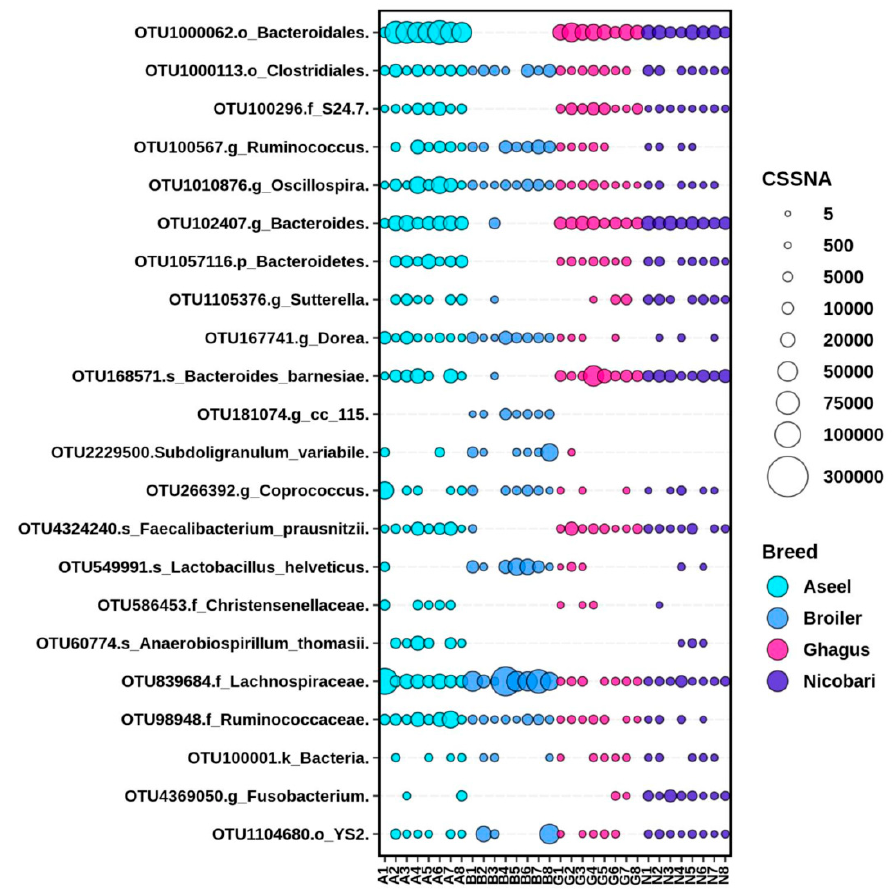
Figure 5. Breed or line-specific and across-breed or line core phylotype-OTUs. Phylotype-OTUs with a mean normalized (cumulative sum scaling) relative abundance of at least 0.1% and having within breed or prevalence of at least 50% in at least one breed were taken into account The size of bubbles in the bubble plot indicates normalized (cumulative sum scaling) abundance of each OTU.